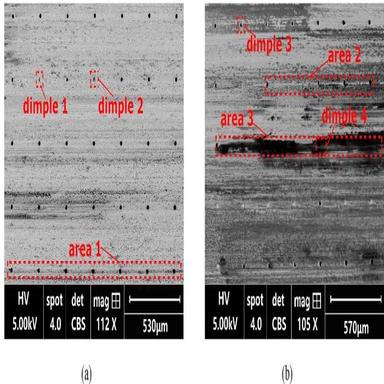
BSE images of the steel counter-surface textured with medium coverage (1.6%) of Type C (wide & shallow) dimples in (a) run-in stage and (b) steady wear stage.